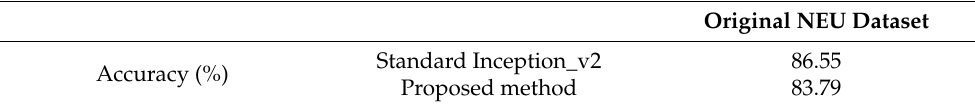
Table 2. The average classification accuracies of standard Inception_v2 and the proposed method with the original NEU